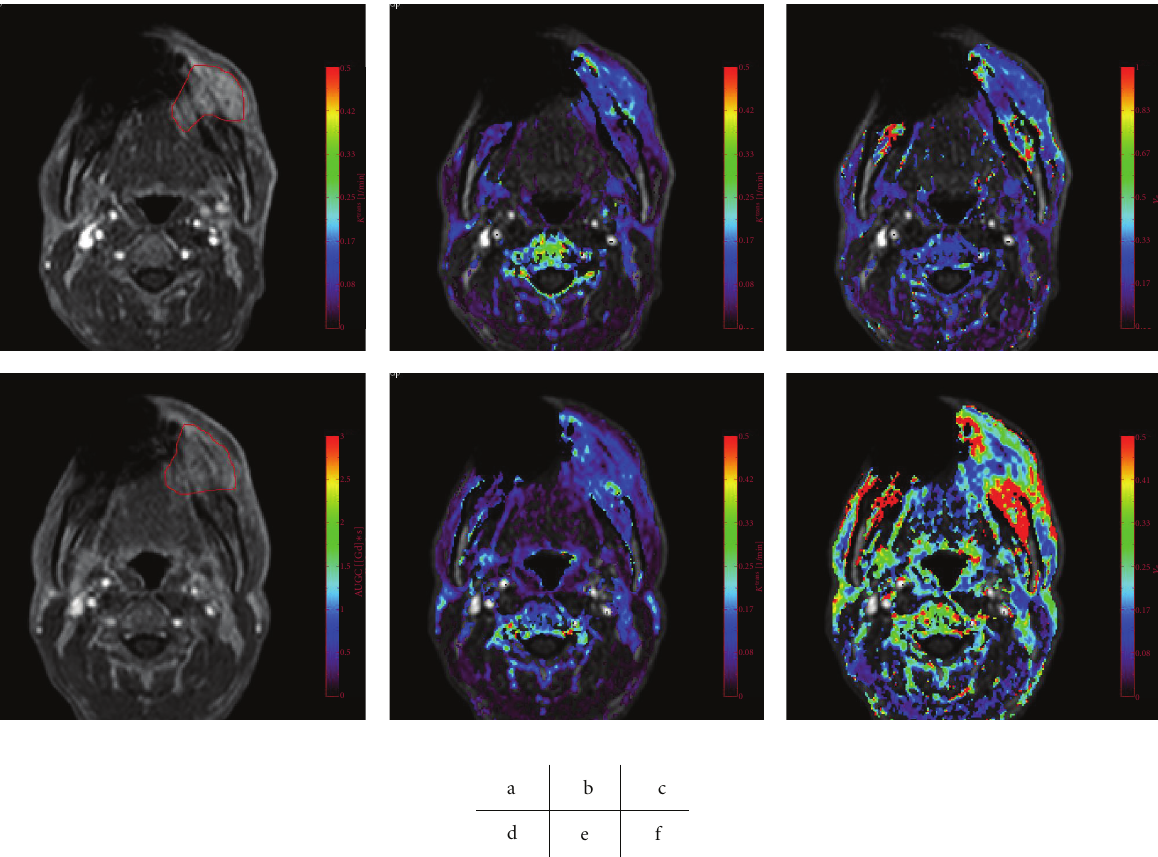
Figure 5: A poor tumor response to CRT, with an Ohboshi and Shimosato classification of I. The analyses were performed using a proprietary software program (PRIDE software, Philips Healthcare, Eindhoven, The Netherlands). Pre-CRT (a–c), Gd-enhanced T 1 WI (a), K trans map (b), v e map (c), Post-CRT (d–f), Gd-enhanced T 1 WI (d), K trans map (e), v e map (f). The tumor ROIs are delineated in red (a, d). The pre-CRT K trans was 0.13 and K trans decreased after CRT with an average of 0.10. v e decrease from 0.28 to 0.23.